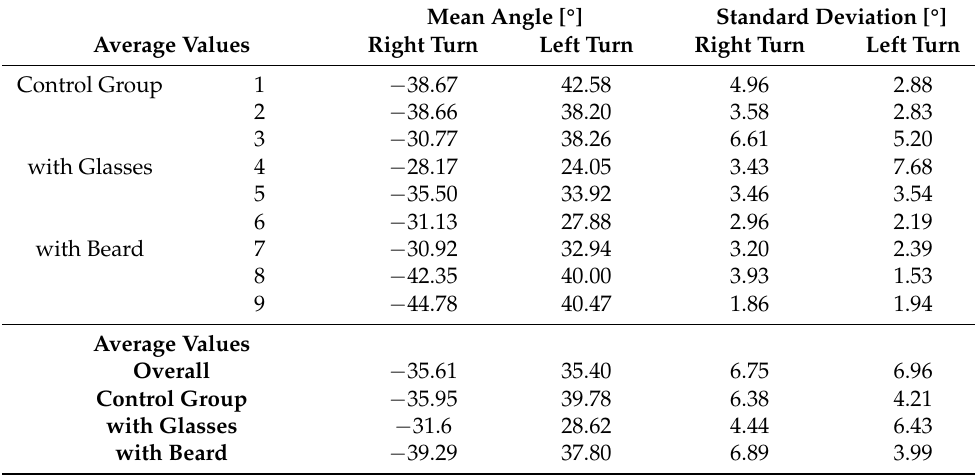
Table A1. Average turning angle for triggering the abort condition per